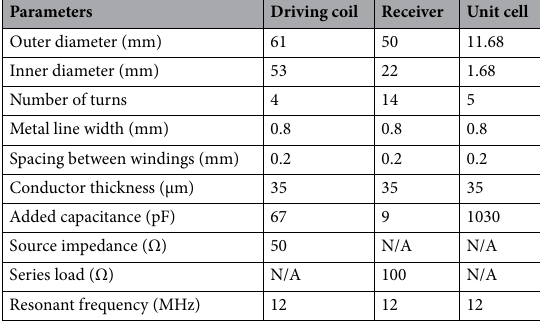
Table 2. Strip system design parameters adopting PCB copper